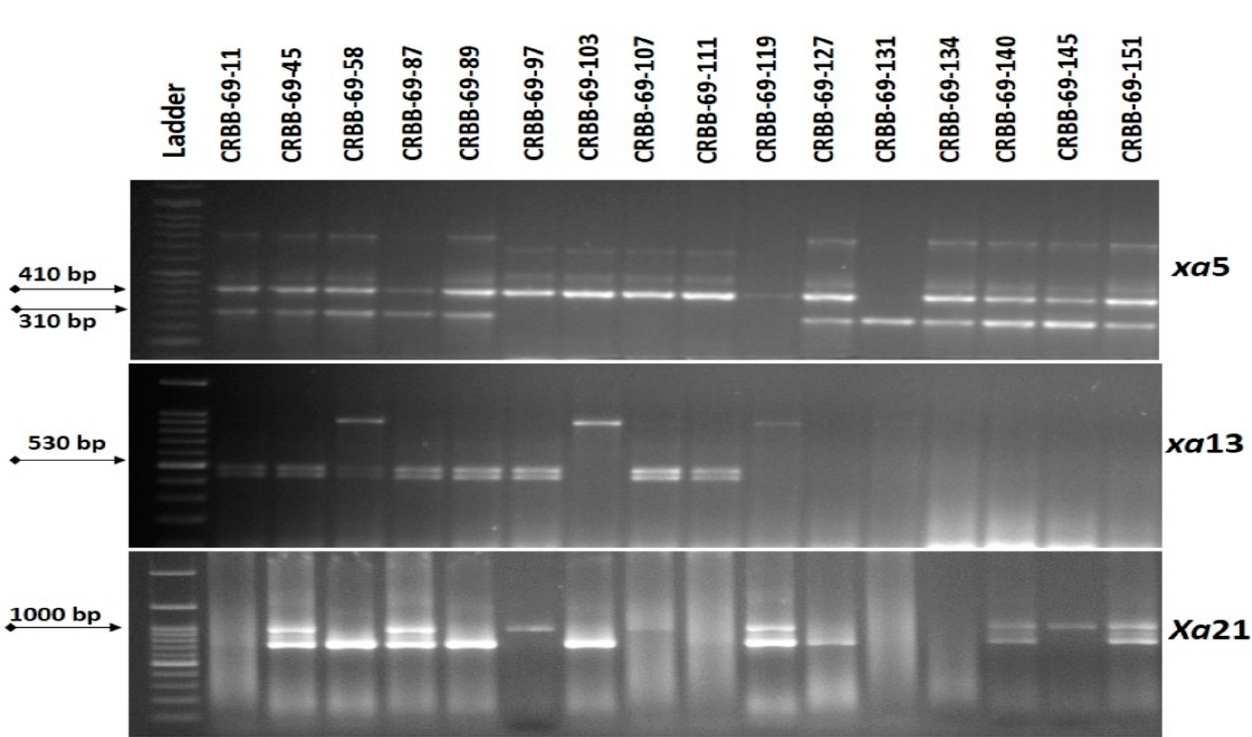
Figure 3. Representative electropherogram generated from the tracking of Xa21 , xa13 and xa5 BB resistance genes in BC 2 F 1 progenies of resistance gene pyramiding of Ranidhan.